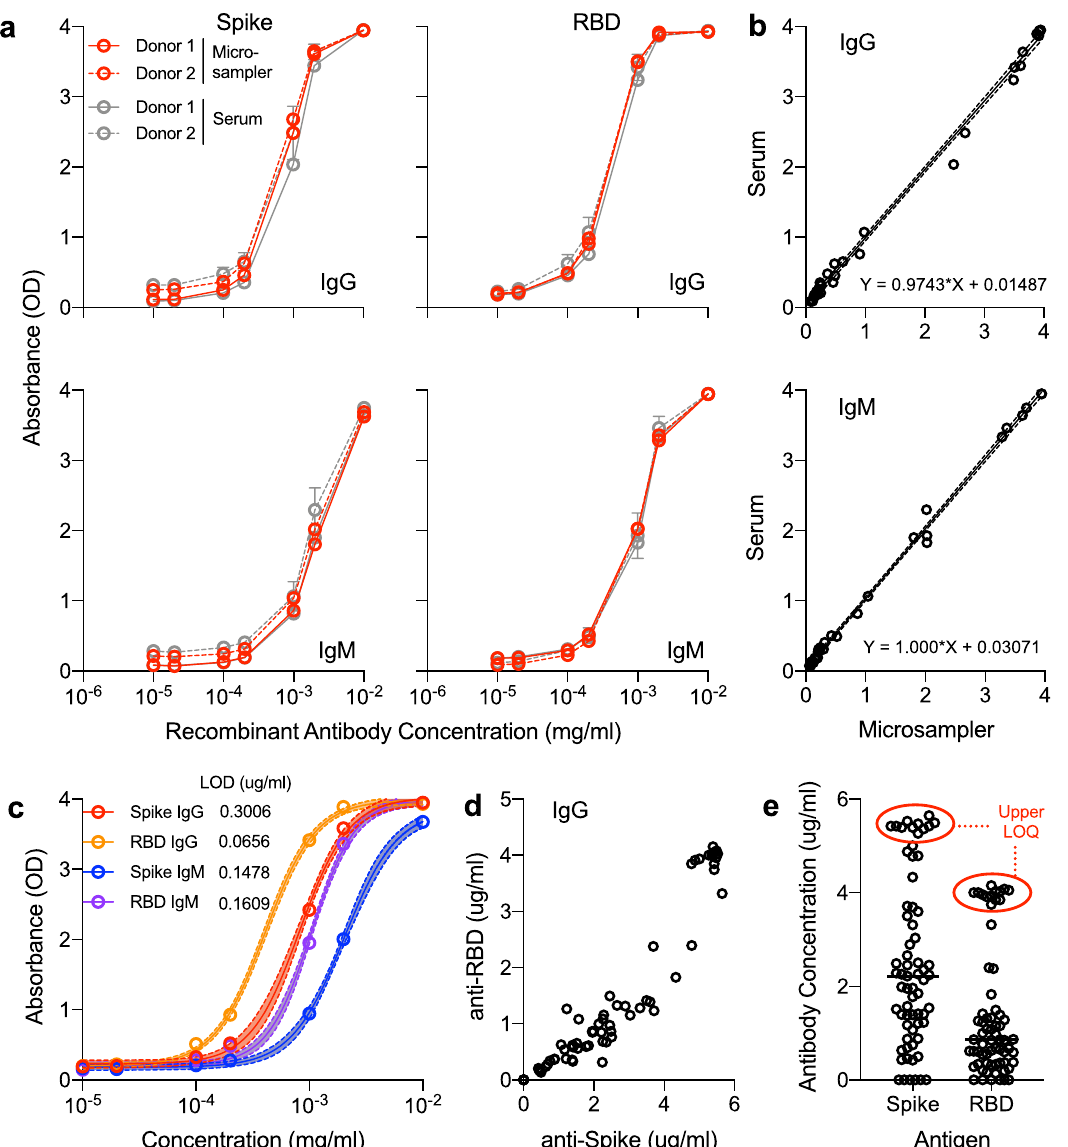
Fig. 5 Quanti fi cation of antibody concentration utilizing 4PL sigmoidal model of recombinant antibody spiked into seronegative blood. a Anti-RBD recombinant human antibody (IgG and IgM) was added to whole blood from two seronegative donors, then absorbed to microsamplers and remaining blood was spun down to isolate serum and analyzed on full spike ectodomain trimer (spike) or receptor-binding domain (RBD) ELISA. Data are mean ± SEM, n = 3, red = microsampler eluate, gray = matched serum. b Direct comparison of absorbance of range of recombinant antibody concentration in serum ( y axis) versus microsampler ( x axis) blood samples. c Sigmoidal four-parameter logistic (4PL) curve fi tting to recombinant antibody dilution series, 95% con fi dence intervals shown shaded around fi t curve, n = 12 replicates per data point, red = Spike IgG, orange = RBD IgG, blue = Spike IgM, purple = RBD IgM. d Quanti fi cation of IgG levels in a sample high-incidence population. e Upper limit of quanti fi cation at 1:400 dilution of serum into ELISA (1:10 dilution of microsampler eluate), n = 68. Source data are provided as a Source Data fi